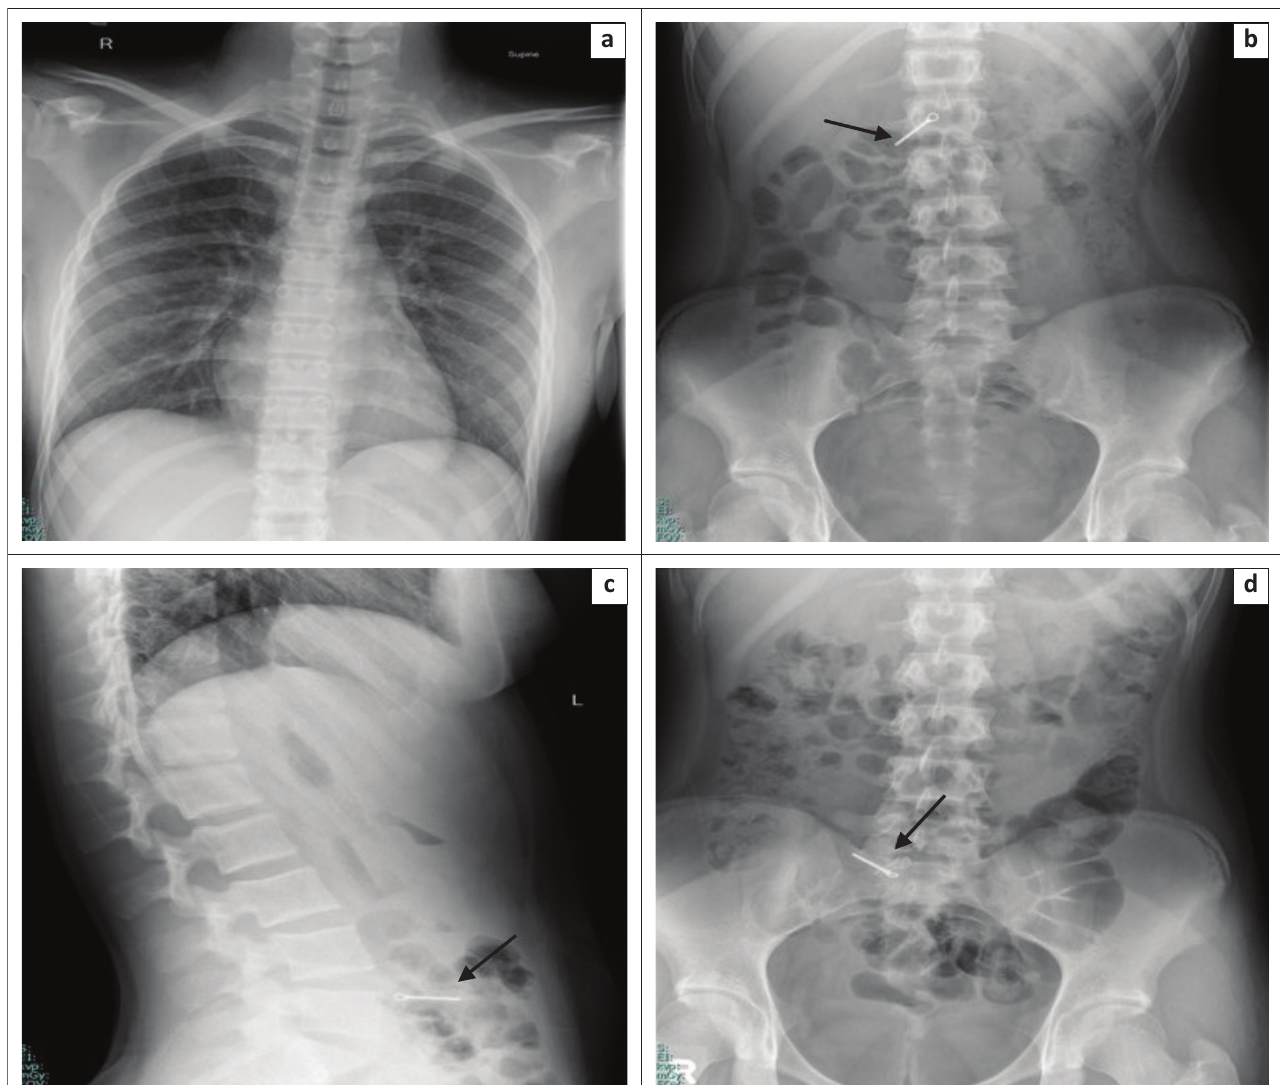
FIGURE 9: Serial radiographs of a 14-year-old-female patient who accidentally swallowed a loose metallic fragment (arrow) from her dental braces. The foreign body had been transmitted from the oesophagus (a) through the gastric pylorus (b), and later into the right lower quadrant (c and d) on follow-up serial radiographs. The patient was managed conservatively without any complications.